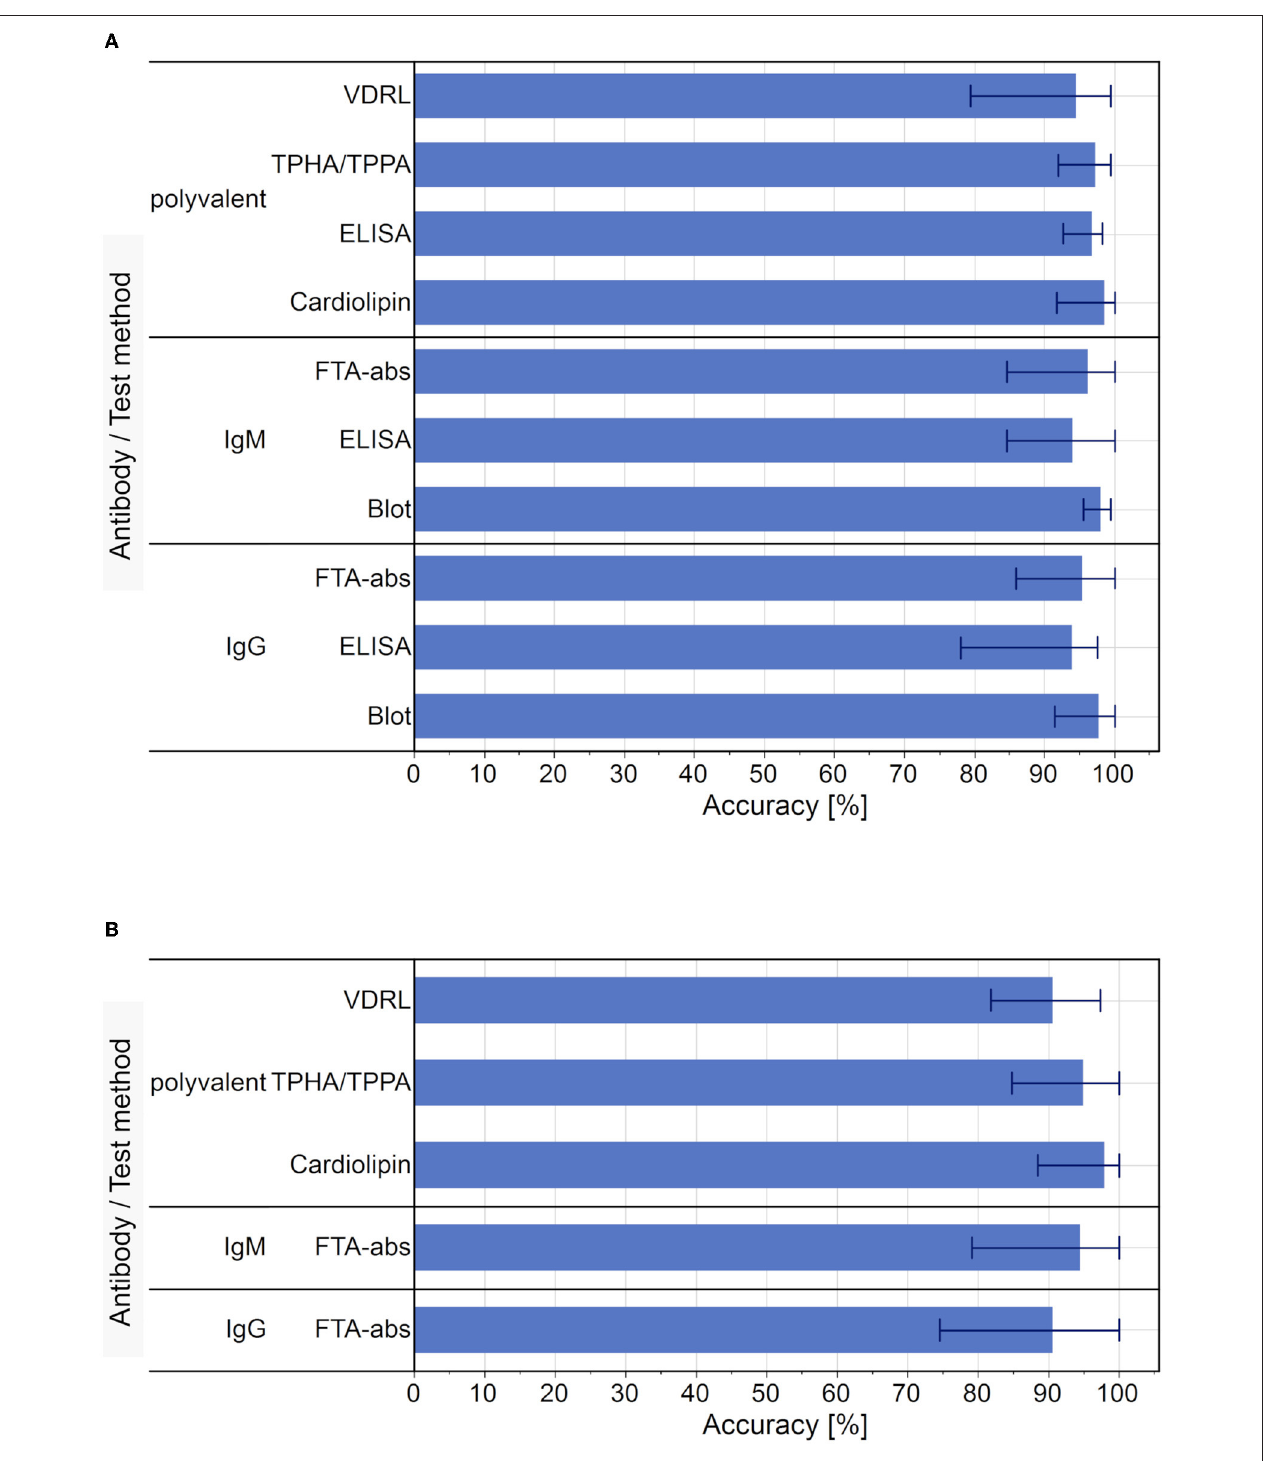
FIGURE 6 | Average accuracy rate of test results for each test used in the EQA surveys, 2010 to 2012. (A) Average accuracy of qualitative test results. Bar markers indicate the range of results. (B) Average accuracy of quantitative test results. Bar markers indicate the range of results. Blot and ELISA tests were not performed as part of the quantitative diagnostic testing for